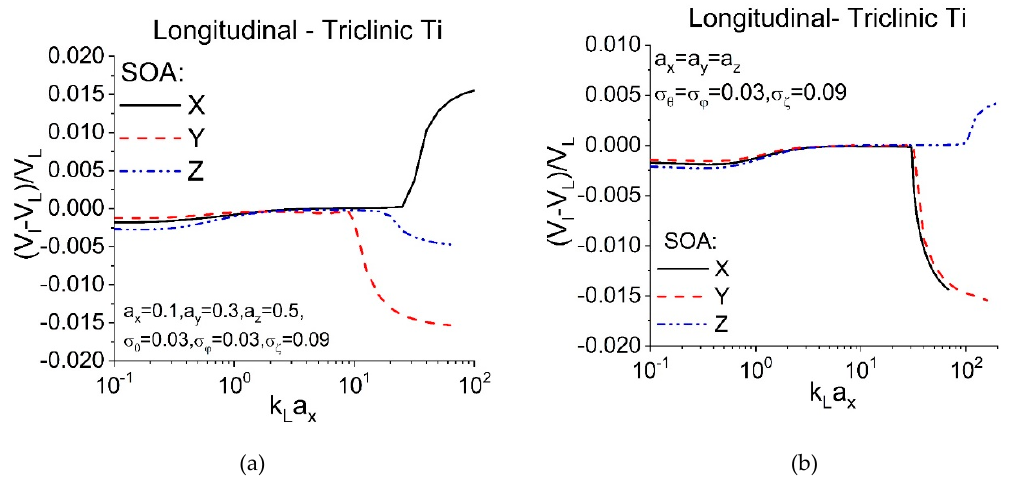
Figure 7. Phase velocity results from the SOA model for two Ti polycrystals with triclinic grains: ( a ) the ellipsoidal grain case and ( b ) the equiaxed grain case. V l is the phase velocity predicted by the SOA model while V L is the Voigt phase velocity in the corresponding wave propagation direction.